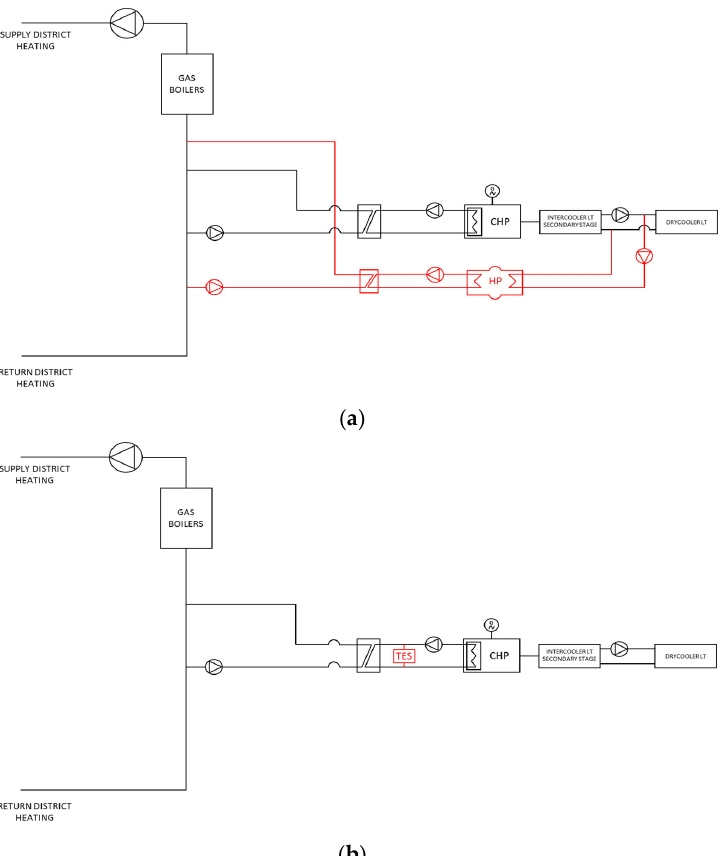
Figure 8. Schematics of the CHP-DH plant configurations and in red, the new technologies: ( a ) configuration with the heat pump (CHP + HP); ( b ) configuration with thermal energy storage (CHP + TES).